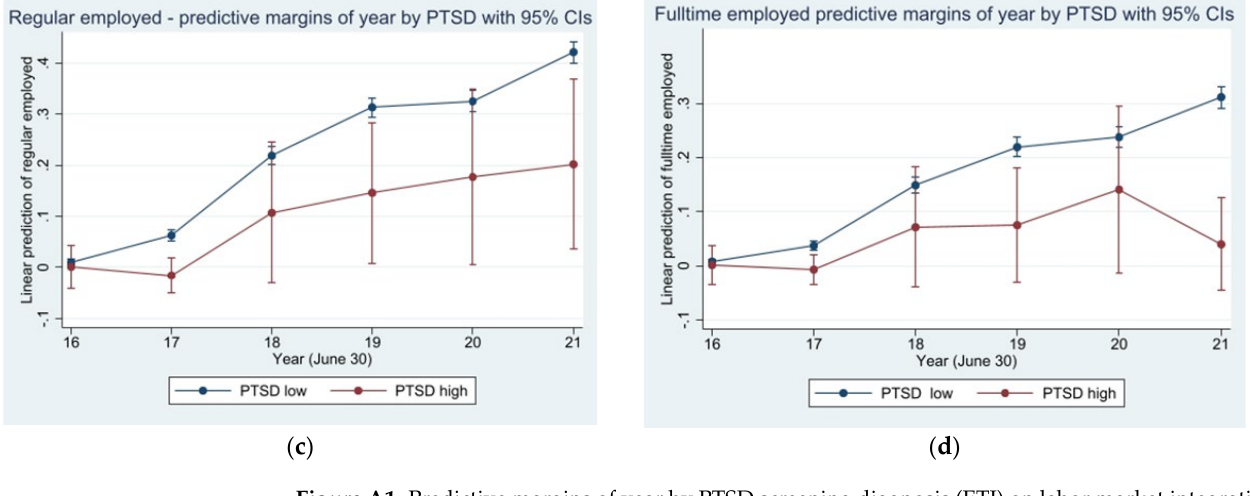
Figure A1. Predictive margins of year by PTSD screening diagnosis (ETI) on labor market integration. ( a ) Labor market integrated (wide definition). ( b ) Employed (full-time, part-time, or marginal employed). ( c ) Regular (full-time or part-time) employed. ( d ) Full-time employed. Source: IAB-WELLCOME study wave 1; IEB, V16.01.